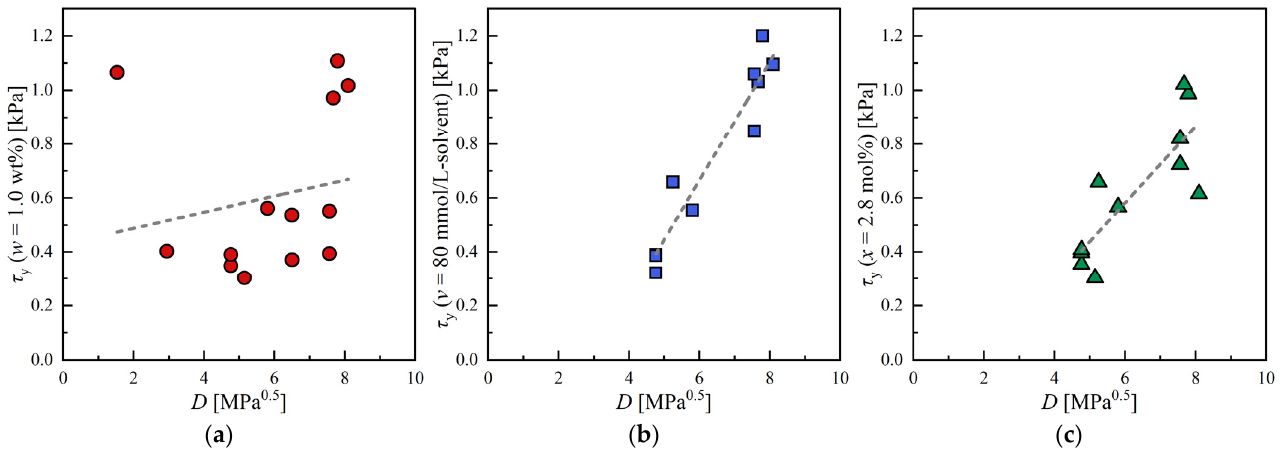
Figure 6. Correlation between yield stress ( 𝜏 y ) and distance in HSP space: ( a ) Fixed concentration at 𝑤 = 1.0% ; ( b ) Fixed concentration at 𝑣 = 80 mmol/L-solvent ; ( c ) Fixed concentration at 𝑥 = 2.8 mol%.